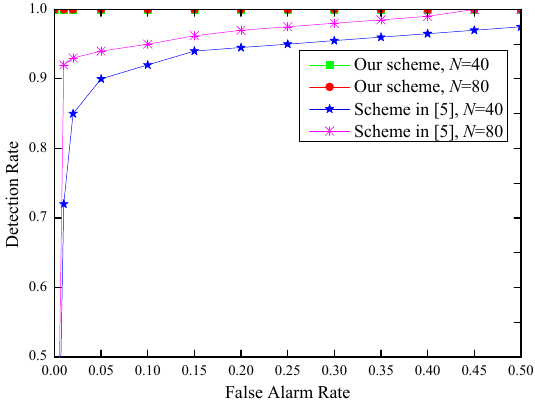
Figure 9. False alarm rate vs. detection rate in indoor environments, N = 40 and N = 80.